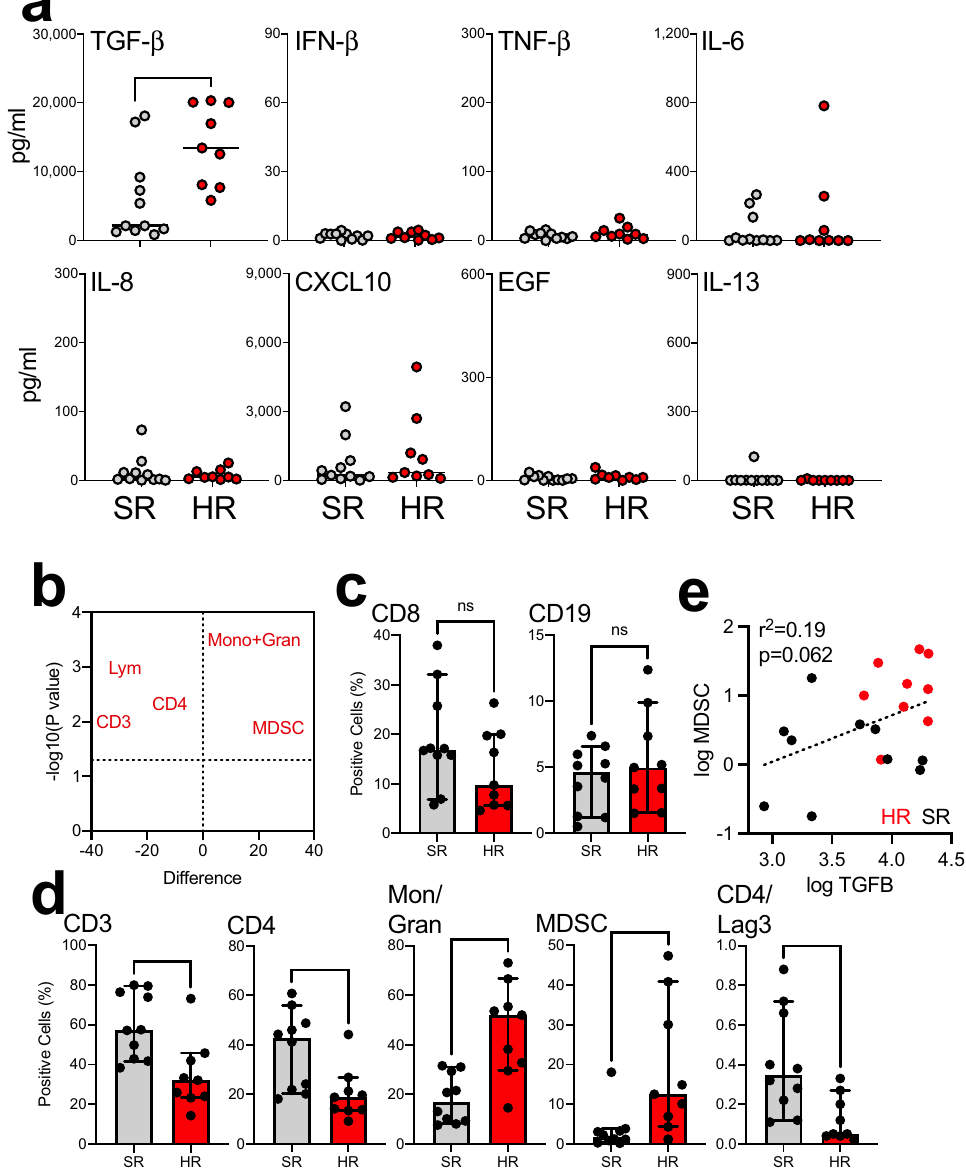
Fig. 4 Analysis of cytokine patterns and T cell phenotypes in COVID-19 patients. a We analyzed cytokine/chemokine levels in the peripheral blood of nine COVID patients who were critically ill (HR = high risk; red dots) and compared them to levels in 11 non-critically ill patients (SR = standard risk; gray dots). b Different lymphocyte subpopulations were quanti fi ed in the peripheral blood of our COVID patients using multicolor fl ow cytometry and subsets discriminating between HR and SR patients were identi fi ed using a volcano plot analysis. c No signi fi cant differences were detected with regard to two different subsets of interest: CD19 + B cells (data indicate percentages of all lymphoctes) and CD8 + T cells (data indicate percentages of all CD3 + lymphoctes). d Patients with HR disease showed lower proportions of total CD3 + T cells (data indicate percentages of all lymphoctes), CD4 + T cells (data indicate percentages of all CD3 + lymphoctes), and Lag-3-expressing CD4 + T cells (data indicate percentages of all CD3 + CD4 + lymphoctes) but